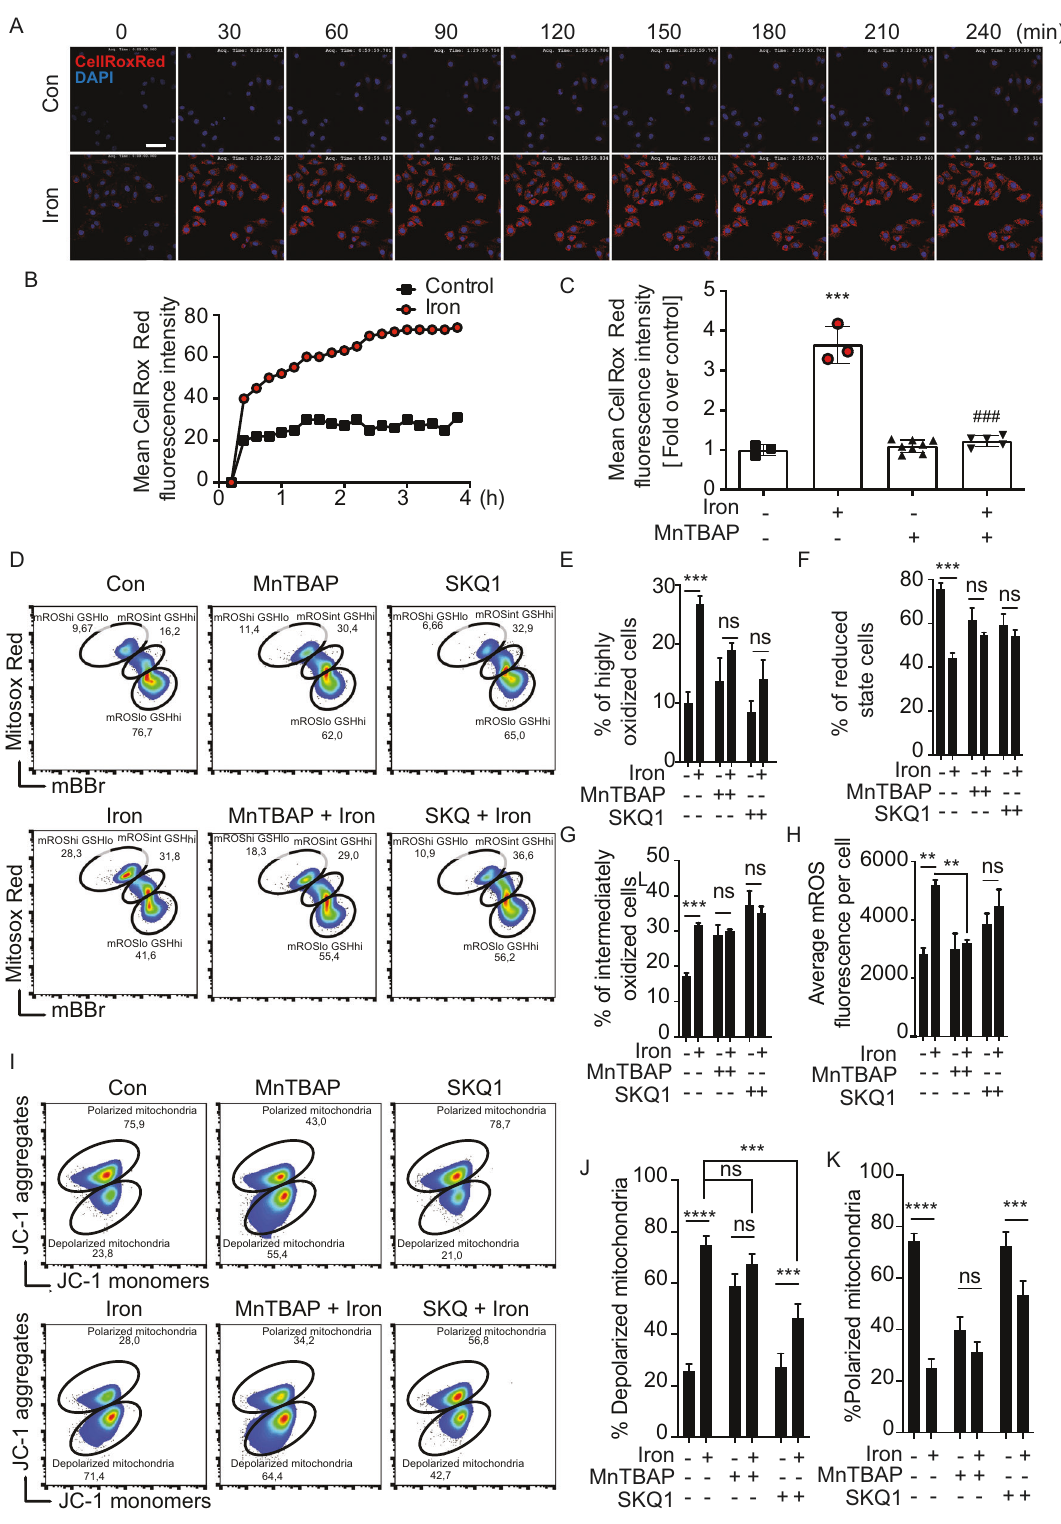
Iron induced ROS production in skeletal muscle cells We next investigated the effect of iron on intracellular reactive oxygen species (ROS) production. This was fi rst performed using the ROS indicator dye CellROX ® red. Representative images from temporal study using live cell imaging are shown in Fig. 2A